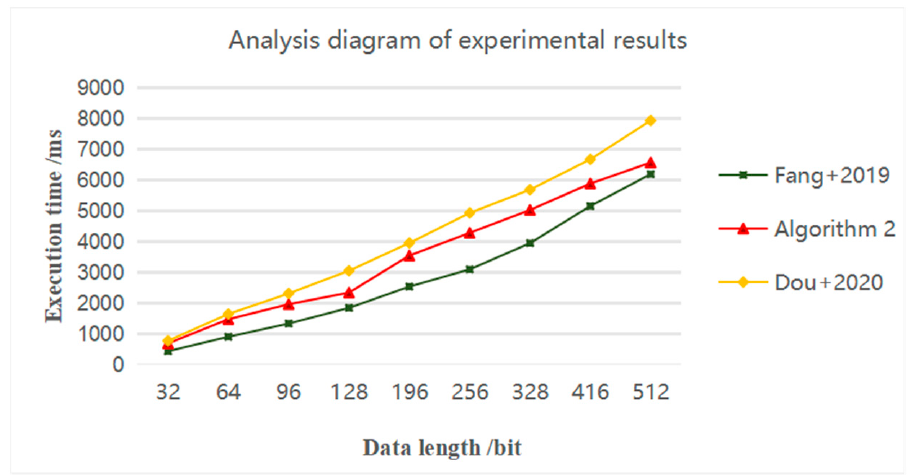
Figure 3. Time of executing protocols in Fang [29], Dou [30], and Algorithm 2.